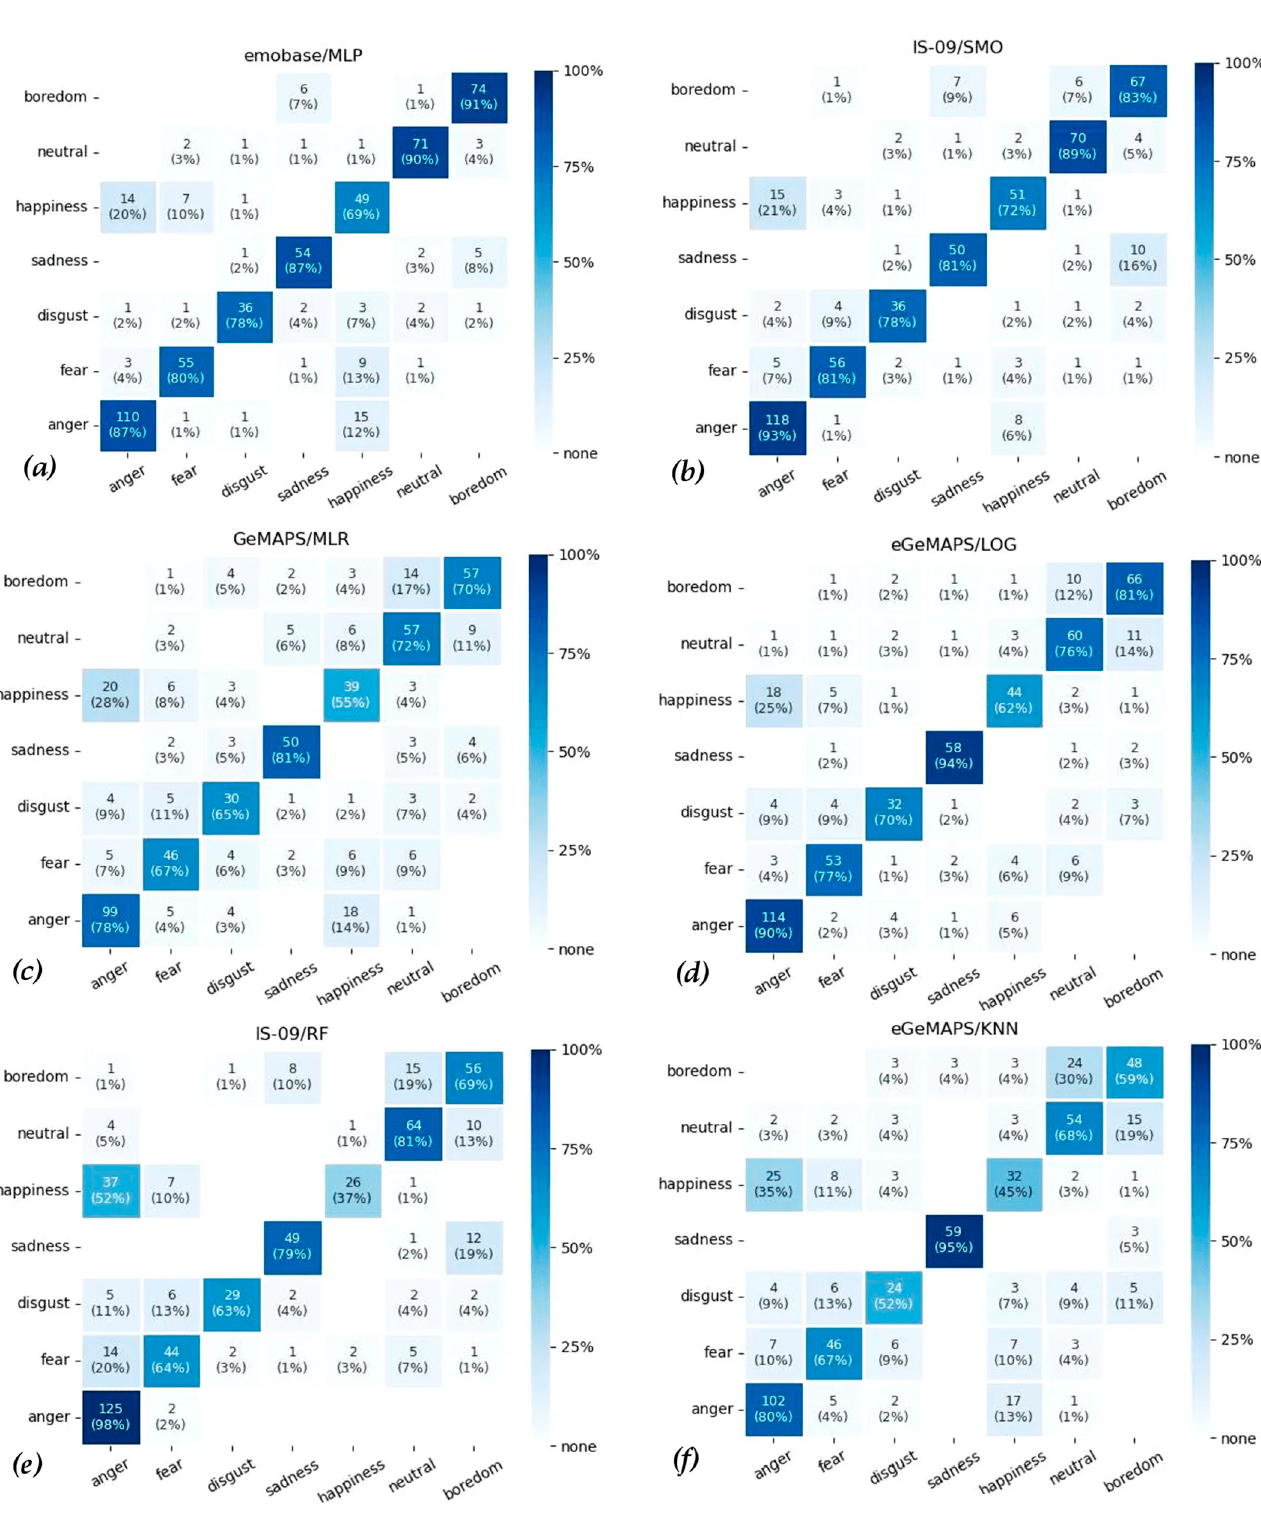
Figure 4. Confusion Matrices of the Predictions With ( a ) emobase/MLP, ( b ) IS-09/SMO, ( c ) GeMAPS/MLR, ( d ) eGeMAPS/LOG, ( e ) IS-09/RF, ( f ) eGeMAPS/KNN. The x -axis represents the ground truth labels and the y -axis represents predicted labels. Note: Figures give percentages determining the color map but also provide absolute numbers in parentheses to transparently indicate different base frequencies of the predicted emotions. Note also that percentages and numbers are omitted for empty cells to enhance